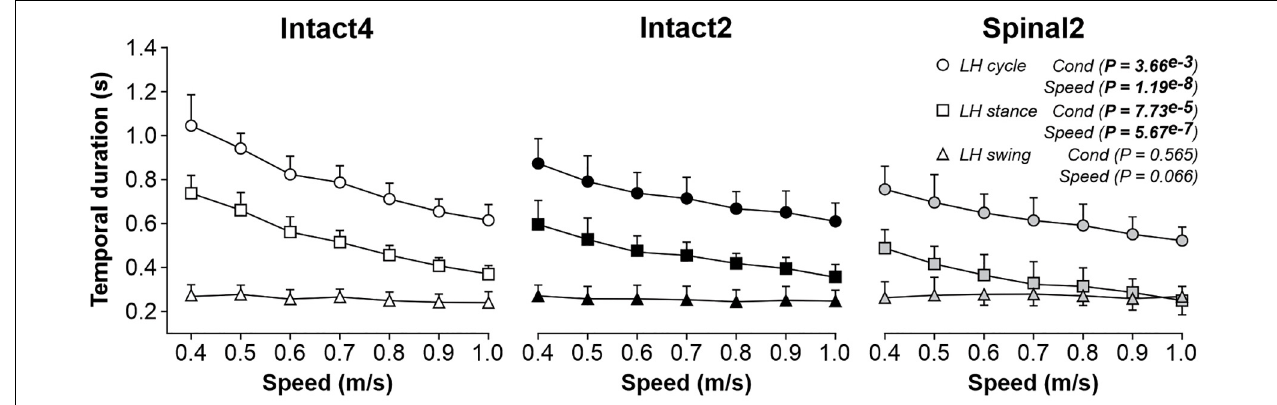
FIGURE 1 | Modulation of temporal parameters during quadrupedal or hindlimb-only locomotion in intact and spinal cats across speeds. Each panel shows cycle, stance and swing durations during Intact4, Intact2 and Spinal2 conditions at seven treadmill speeds. At each speed, we averaged 6–15 cycles per cat. Each data point indicates the mean ± SD for the group ( n = 9 cats). P values comparing conditions (Cond) and speeds are indicated (main effects of repeated-measures ANOVA).